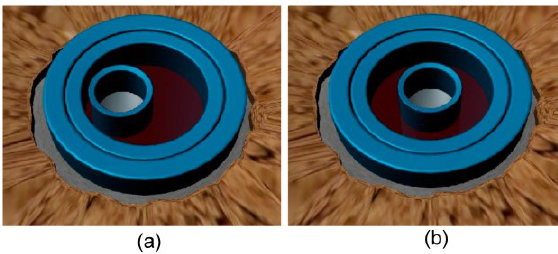
Fig. 6: Plan (a) eccentric in the domain D and plan (b) concentric in the domain I.